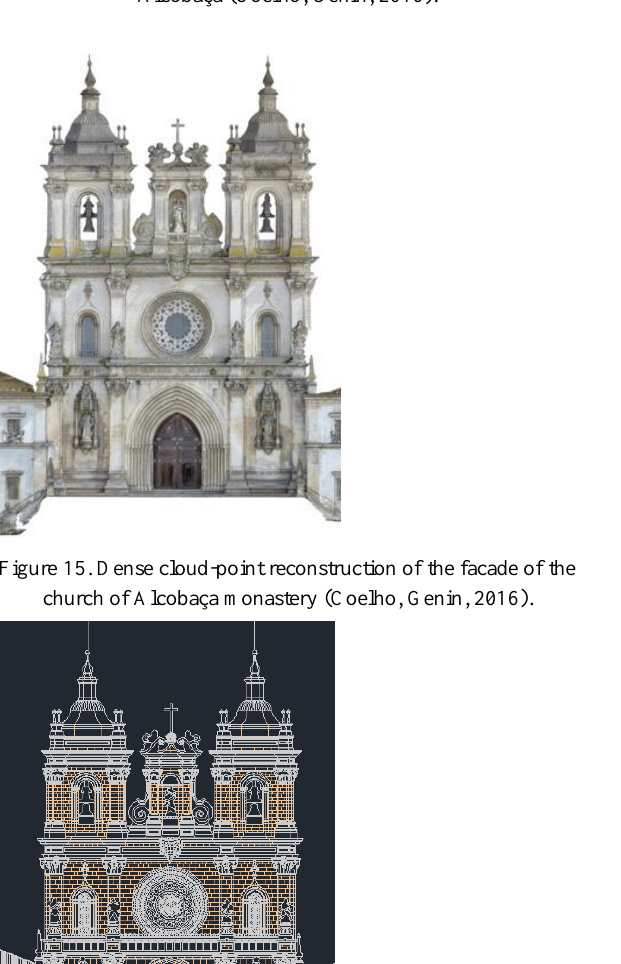
Figure 14. Location of the five control points for the photogrammetric survey of the facade of the monastery of Alcobaça (Coelho, Genin, 2016).